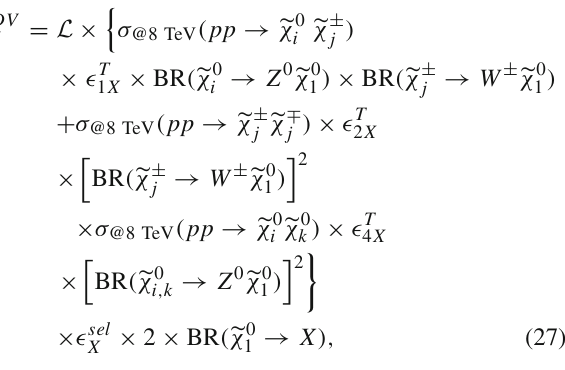
that this variety of possible signals can be constrained using LHC searches, and explained the analysis to be carried out. The results of the computation of the LHC limits imposed on the parameter space of our scenario are presented in Fig. 13, which can be compared with those of Fig. 9. The (green and blue) viable points of Fig. 9 are shown in Fig. 13 with light colors when they are excluded by LHC searches. Processes considered relevant for these searches, (cid:2) (cid:2) (cid:2) (cid:2) W ∓ W ± or W ± production, are W 0 such as those initiated by expected to decrease their exclusion power with increasing values of M 2 . This is the case for (sneutrino LSP-like) points in the right part of the plot which are allowed by the analysis of these processes (up to M 2 = 920 GeV). However, at the end of the day most of them turn out to be excluded, as can be seen in Fig. 13, and only a bunch compatible with (cid:3) a μ at the 2 σ level survives with 460 < ∼ M 2 < ∼ 660 GeV (and (cid:2) 270 GeV). These values of M 210 < ∼ m (cid:2) ν 2 μ